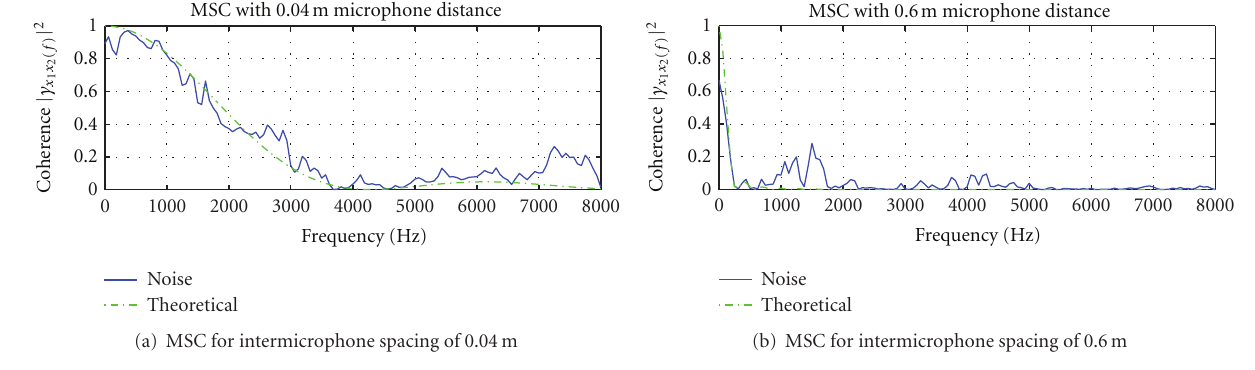
Figure 6: Comparison of the magnitude squared coherence.